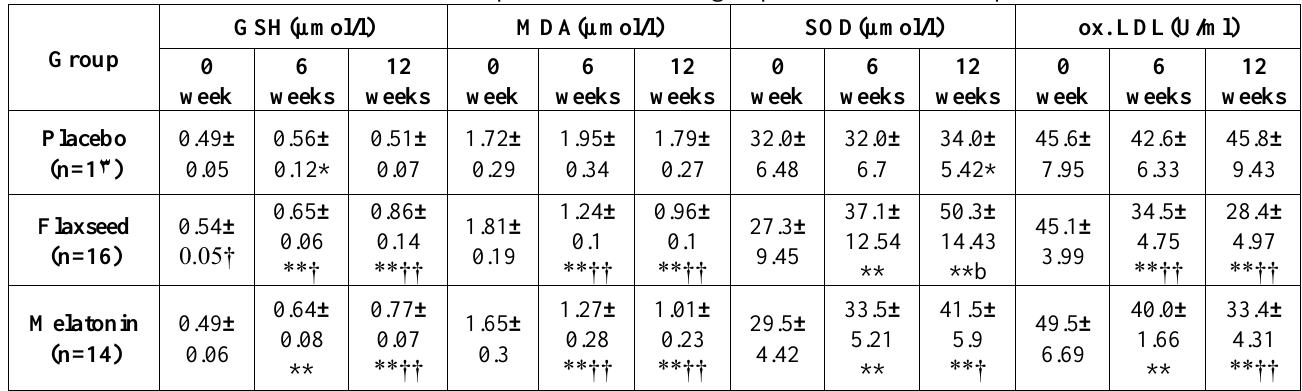
Table 2: Oxidative stress parameters in each group at varied treatment